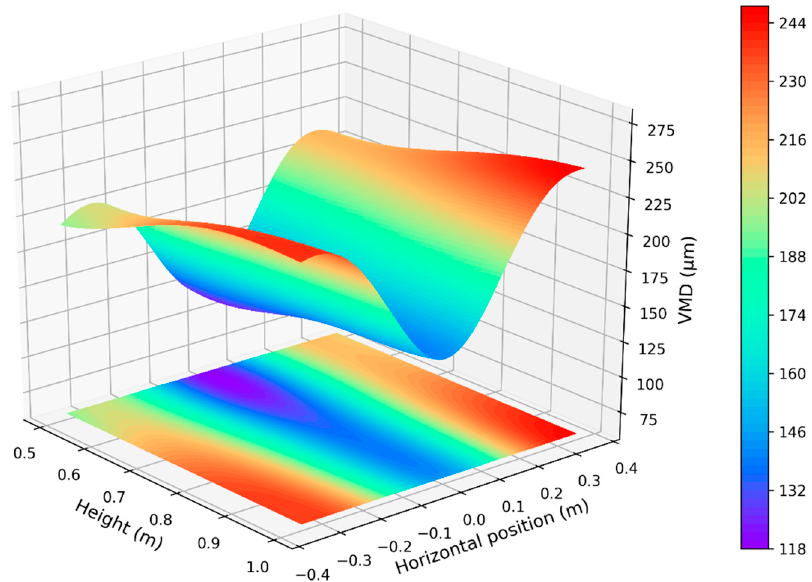
Figure 6. Visualization of VMD distribution.